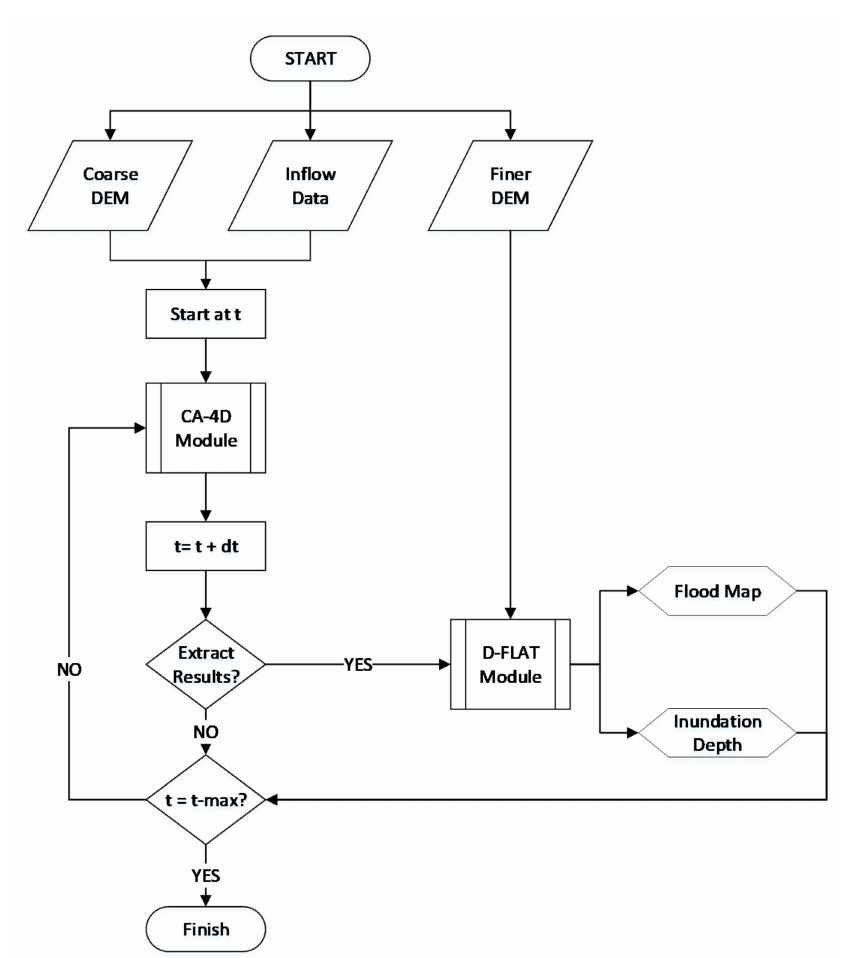
Figure 1. Flowchart of the